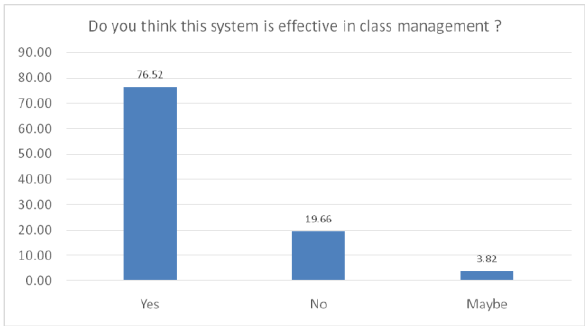
Figure 6. The effectiveness of the system in class